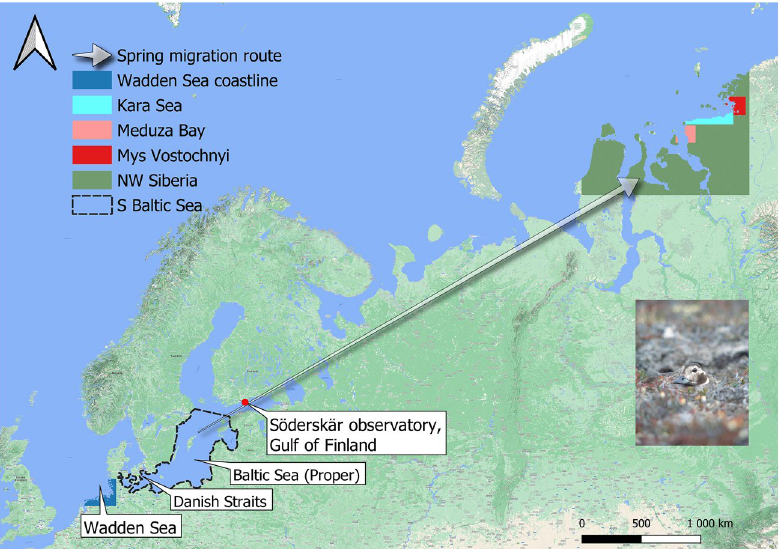
Figure 1. Study areas from the Wadden Sea, Denmark, and the Gulf of Finland extending to the Western Taimyr Peninsula, North-western Siberia, Russia. Colours indicate regions for which map-based climatological variables were calculated. The coastal areas of the southern Baltic Sea form the main wintering area of long- tailed ducks breeding in North-western Siberia. The spring migration surveys were conducted at Söderskär. Mussels were surveyed on the Wadden Sea, and lemmings in the Western Taimyr Peninsula: Kara Sea, Meduza Bay, and Mys Vostochnyi. This map was created using the free and open source QGIS (version 3.12 ‘Bucure ș ti’, https:// www. qgis. org/). Female long-tailed duck image by Antti Below.